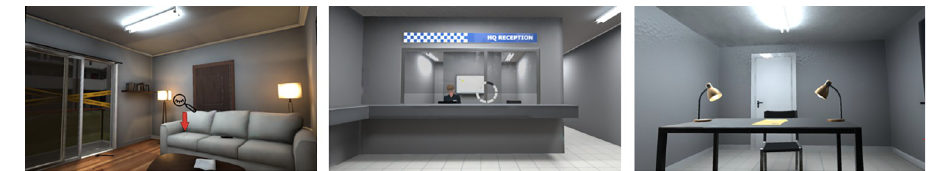
Fig 3. Rooms used in Experiment 2. Left: Crime Scene; middle: Foyer; right: Interrogation Room.